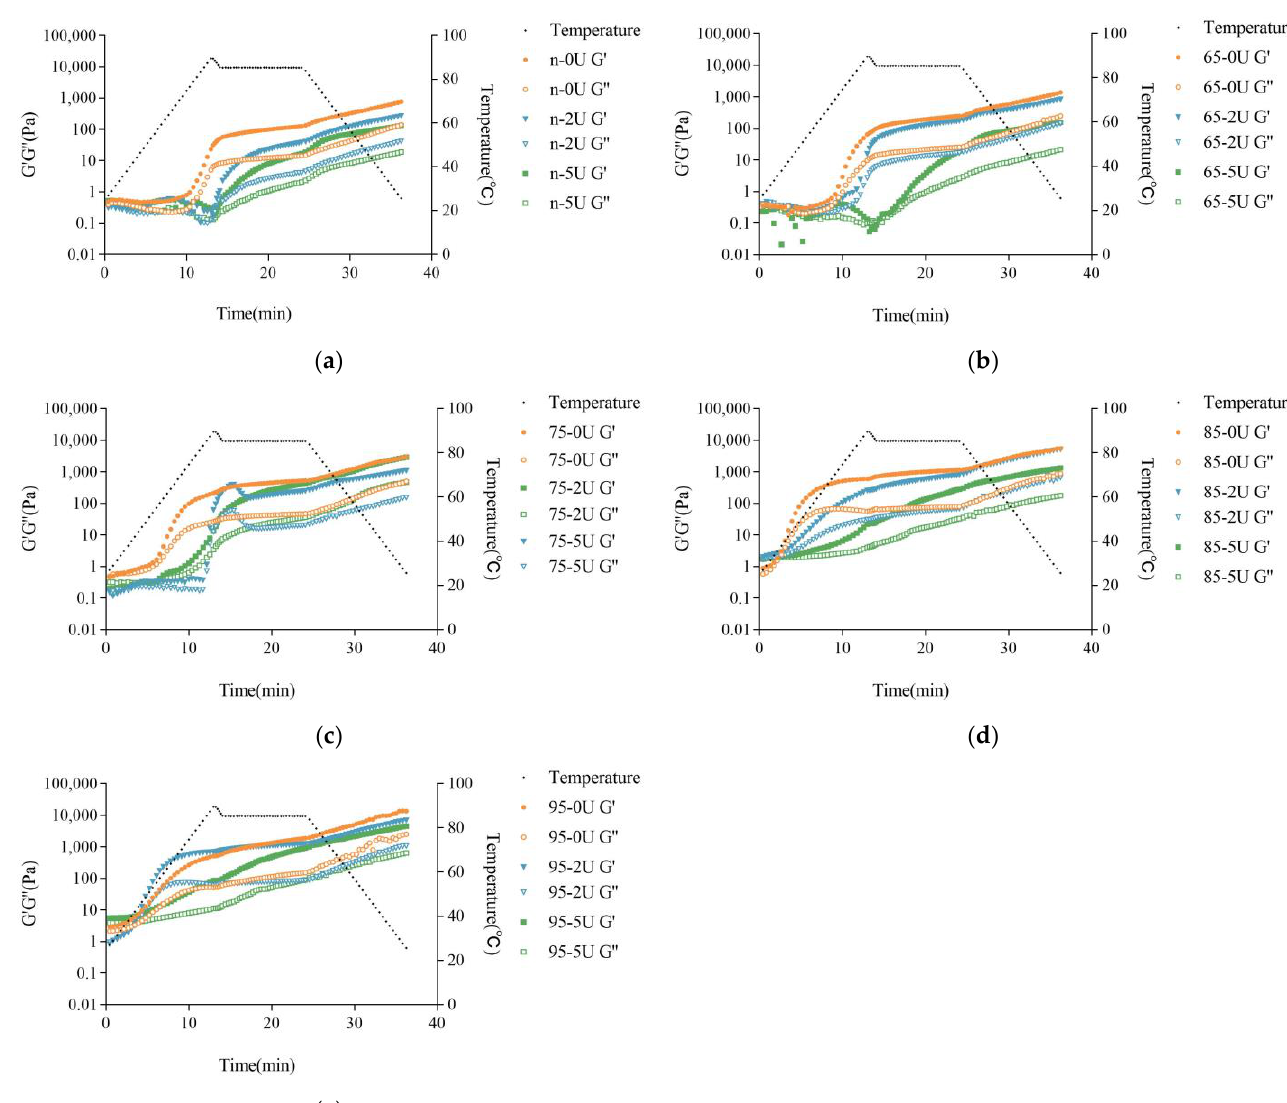
Figure 4. Rheological properties of the soy protein with different heating levels and PG-treated after calcium addition. ( a ): native SPI with different PG-treated levels; ( b ): preheated SPI at 65 °C with different PG-treated levels; ( c ): preheated SPI at 75 °C with different PG-treated levels; ( d ): preheated SPI at 85 °C with different PG-treated levels; ( e ): preheated SPI at 95 °C with different PG-treated levels.